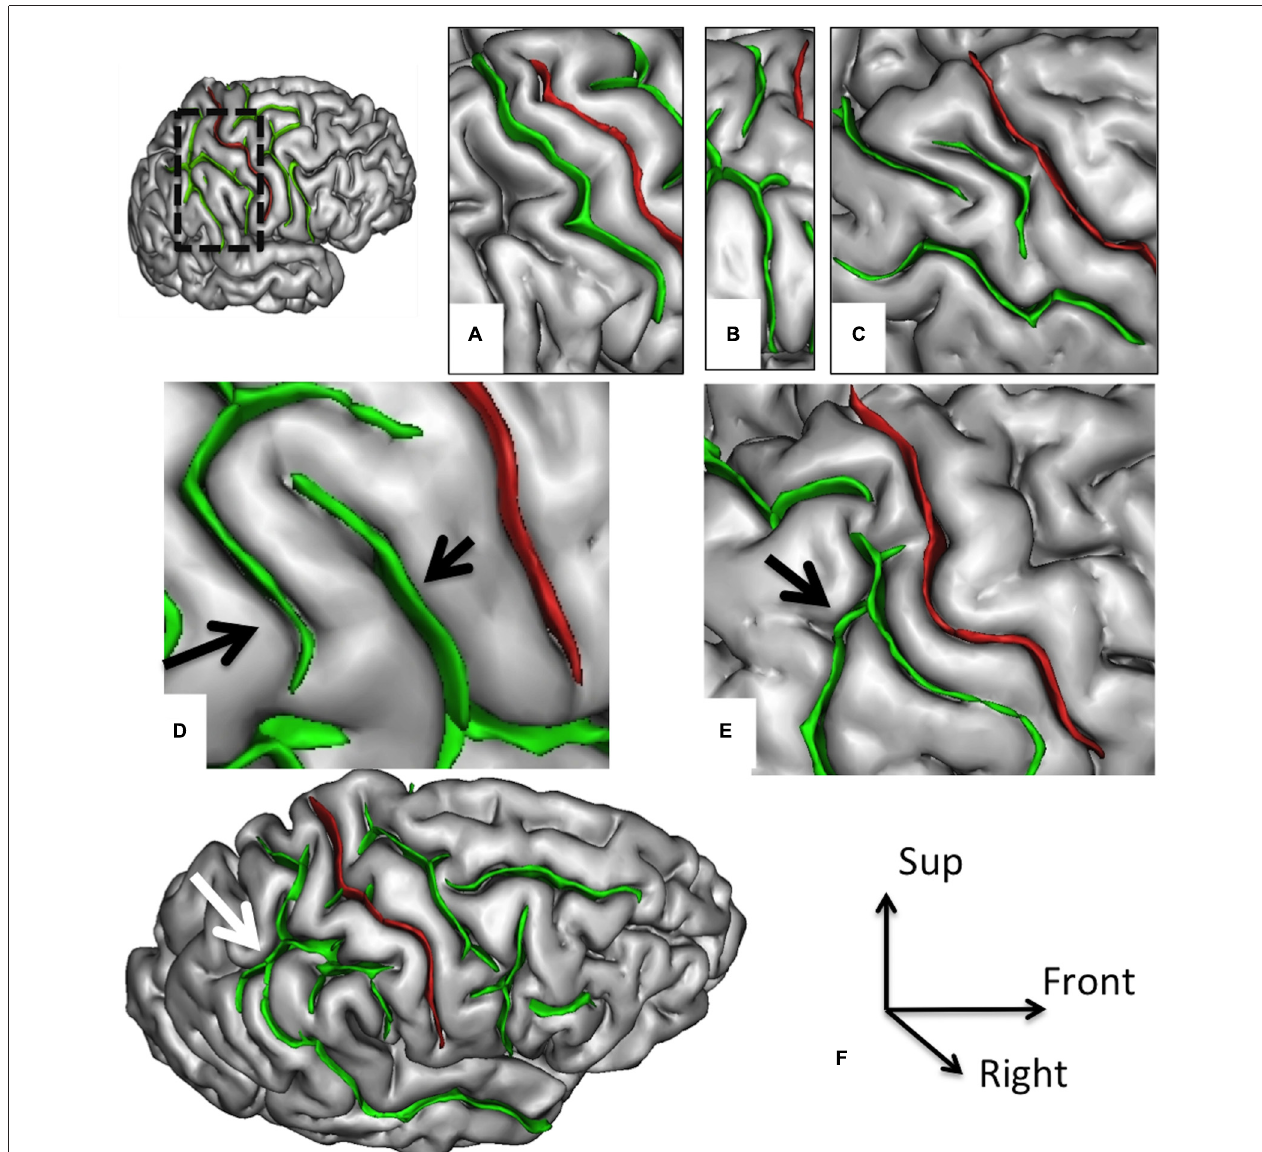
FIGURE 3 | Morphological features of the postcentral sulcus (PostCS) with an excellent inter-rater concordance ( κ > 0.80) and with values (frequency occurrence) that do not differ from Ono’s post-mortem values. The PostCS (in green) represented on a 3D mesh-based reconstruction of the cortex surface. PostCS with one (A) , two (B) or three (C) segments. PostCS double parallel pattern ( D , arrows). PostCS connections with intraparietal sulcus ( E , arrow) or with superior temporal sulcus ( F ,